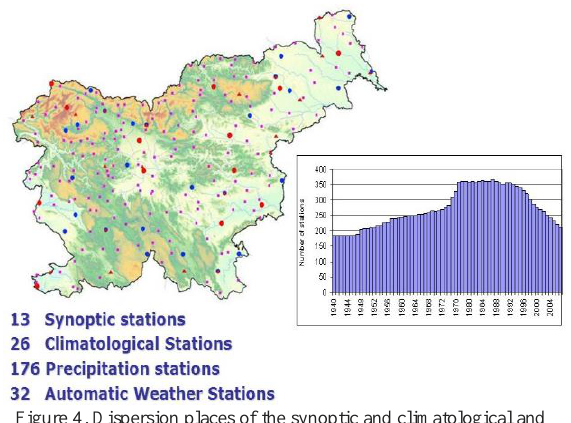
Figure 4. Dispersion places of the synoptic and climatological and precipitation stations in Urmia Lake basin